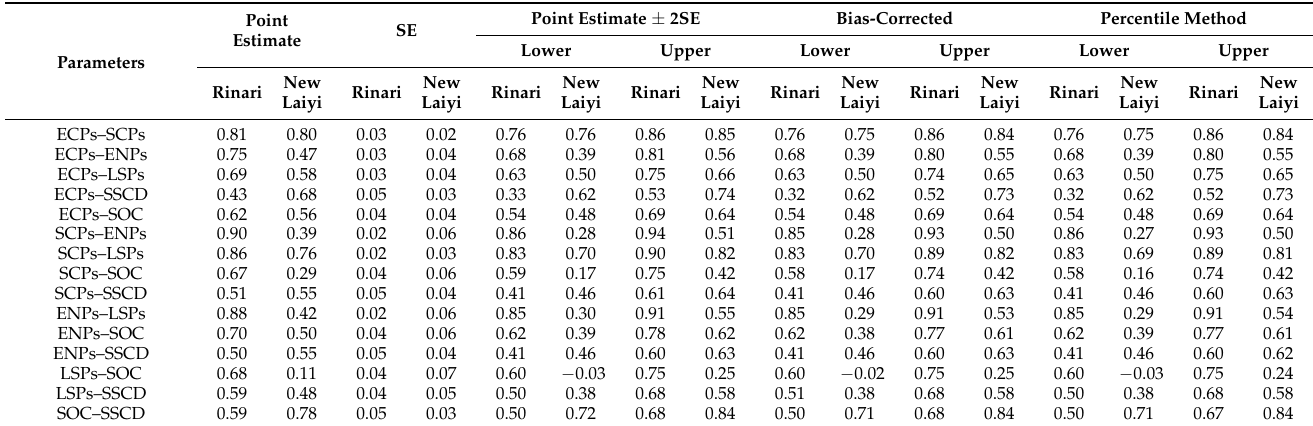
Table 5. Discriminant validity of confidence interval.